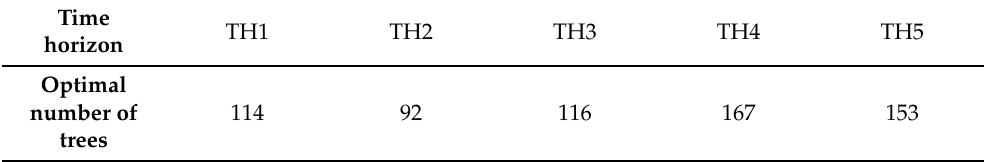
Table 4. Results of the sensitivity analysis on the RF number of